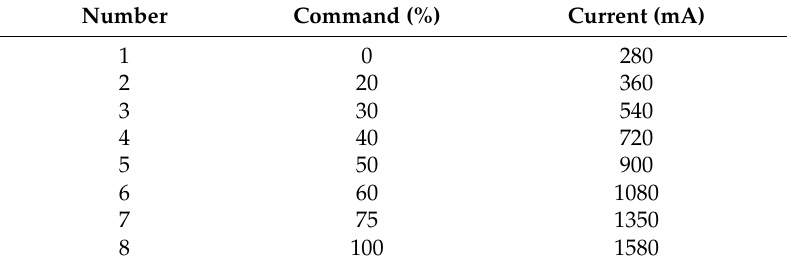
Table 3. Current conditions of test for force-velocity curve.